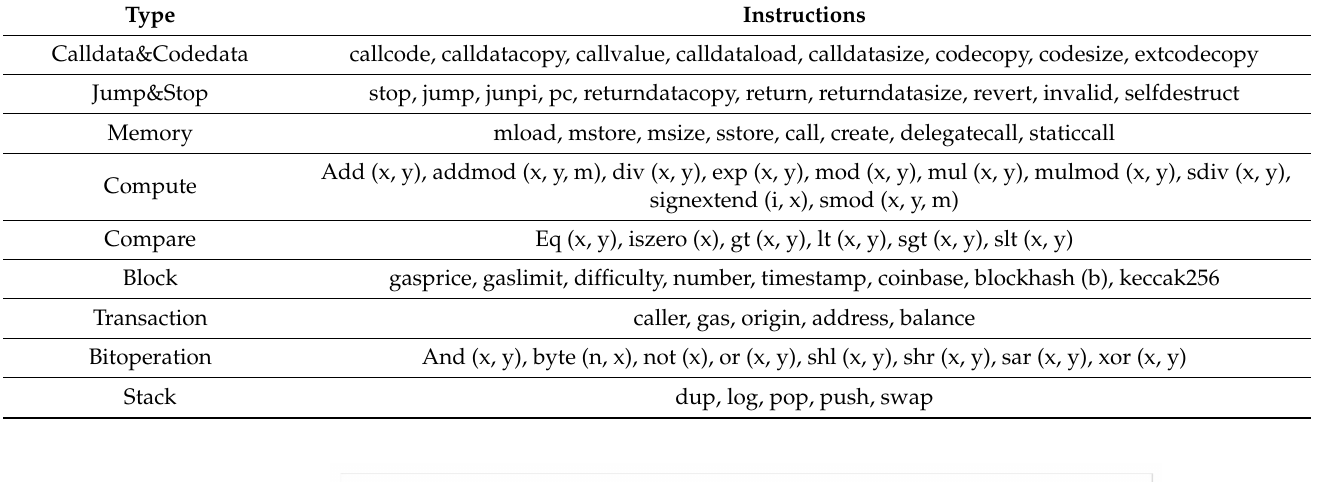
Table 3. Operation code category division.